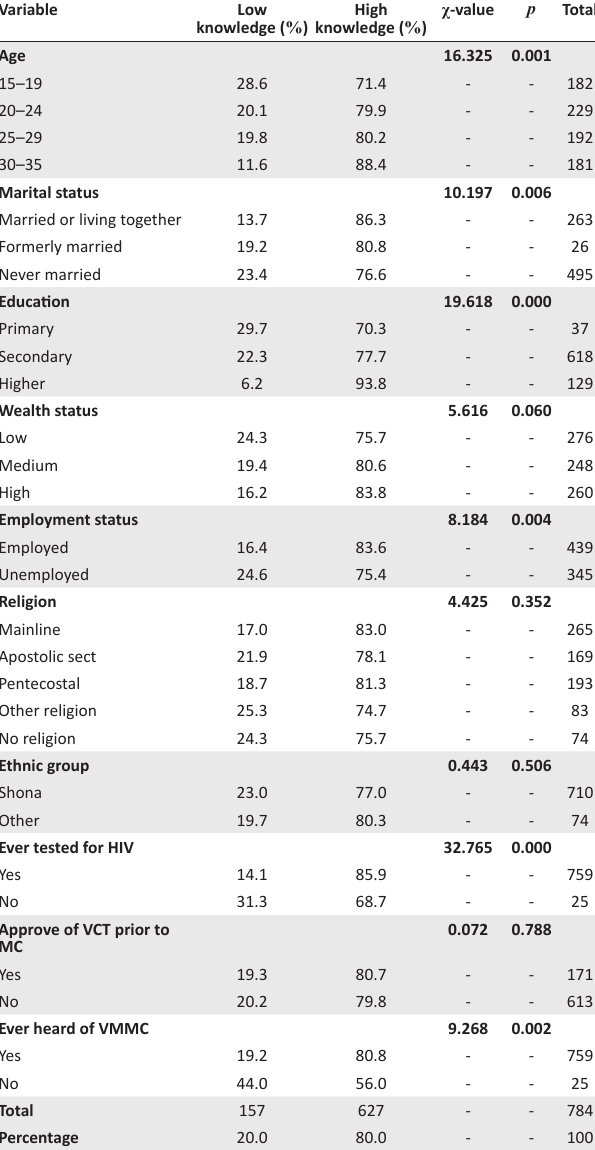
TABLE 4: Predictors of knowledge about male